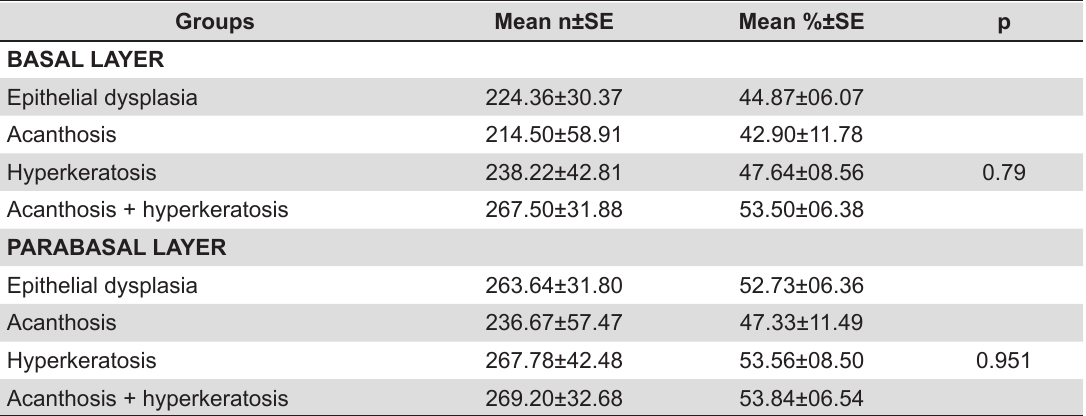
Table 2- Distribution across groups of mean numbers and mean percentages of p53 positive cells with standard errors (±SE) for the basal and parabasal layers